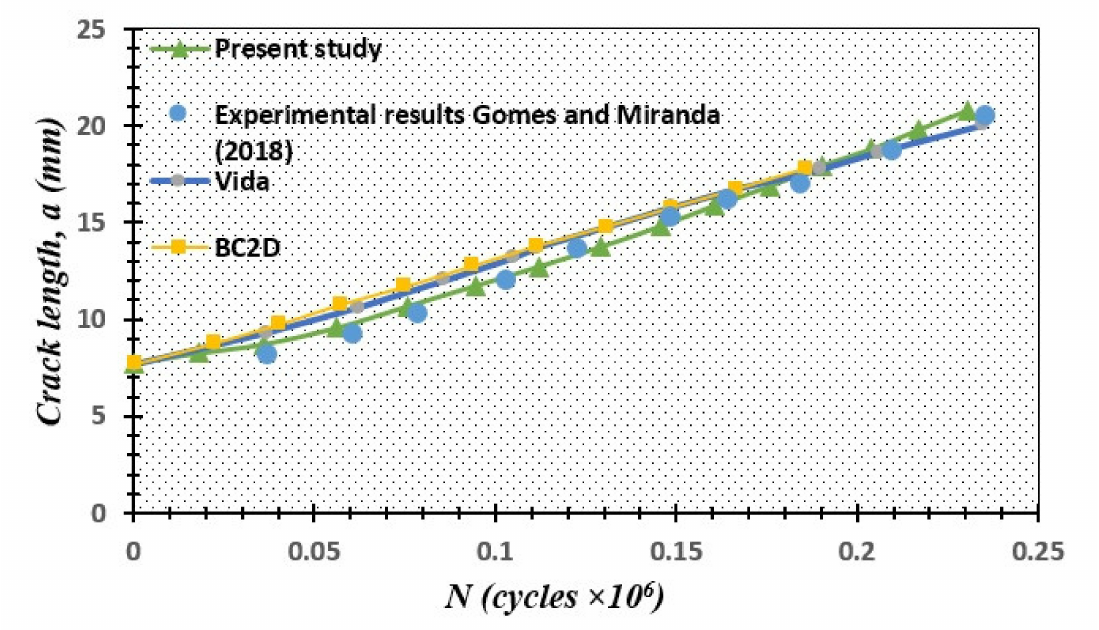
Figure 18. Fatigue life for the modified compact tension specimen